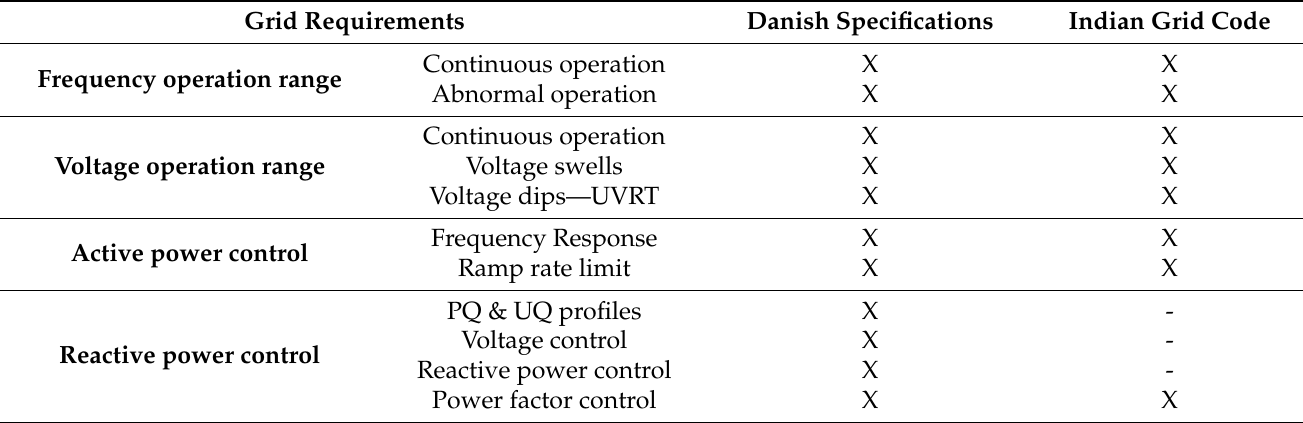
Table 7. Overview of grid code requirements in Denmark and